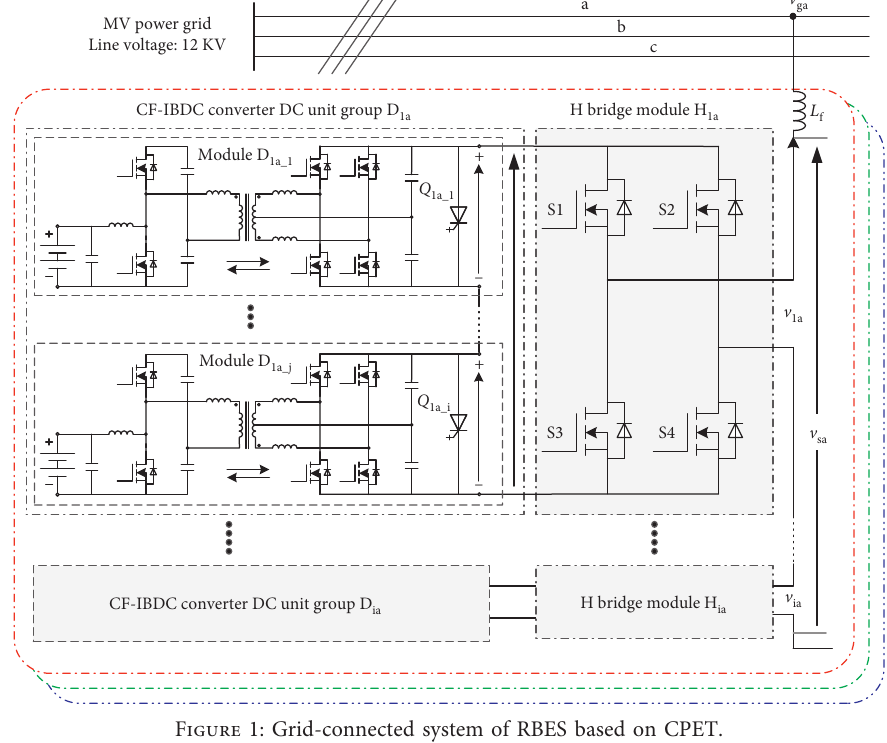
Figure 1: Grid-connected system of RBES based on CPET.